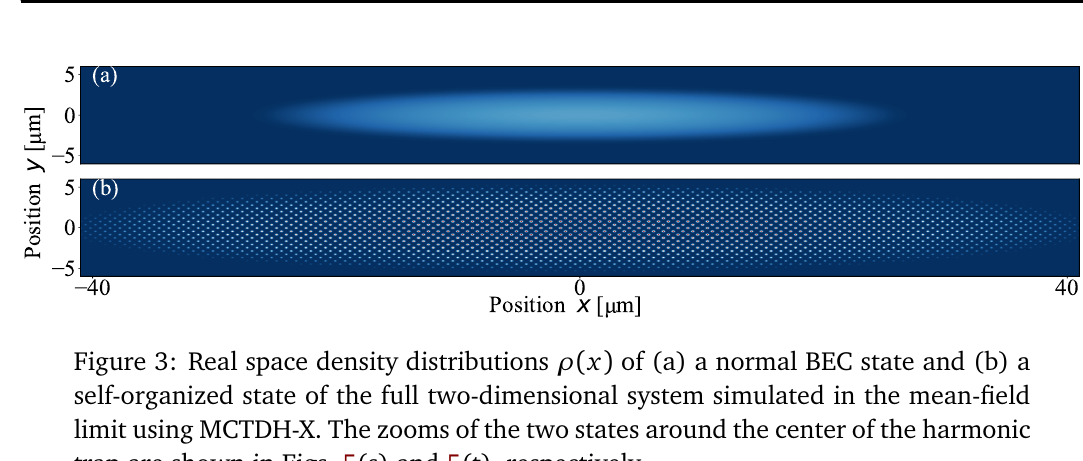
Figure 3: Real space density distributions ρ ( x ) of (a) a normal BEC state and (b) a self-organized state of the full two-dimensional system simulated in the mean-field limit using MCTDH-X. The zooms of the two states around the center of the harmonic trap are shown in Figs. 5(s) and 5(t),